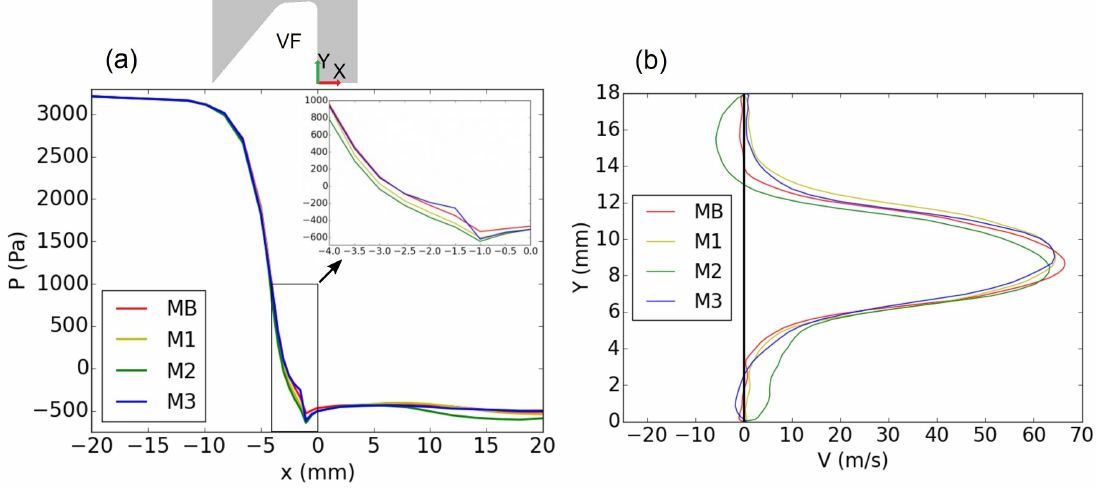
Figure 13. Time-averaged ( a ) static pressure distribution at the center axis of the mid-coronal plane and ( b ) velocity profile in a cross-section of the mid-coronal plane 8 mm downstream of the glottal exit (P1 in Figure 1) for all the grids.